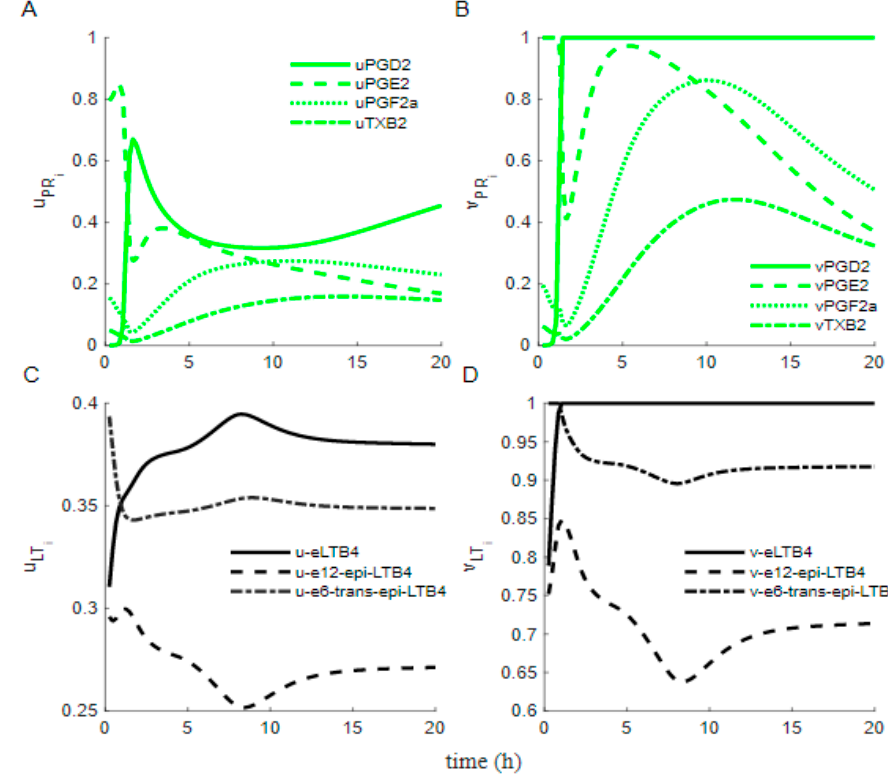
Figure 5. Profiles for the cybernetic control variables for PRs— 𝑢 (cid:3017)(cid:3019) 𝑢 (cid:3013)(cid:3021) ( C ) and 𝑣 (cid:3013)(cid:3021) ( D ) for the ATP-stimulation experiment. For the PRs, cybernetics is applied at (cid:3284) (cid:3284)